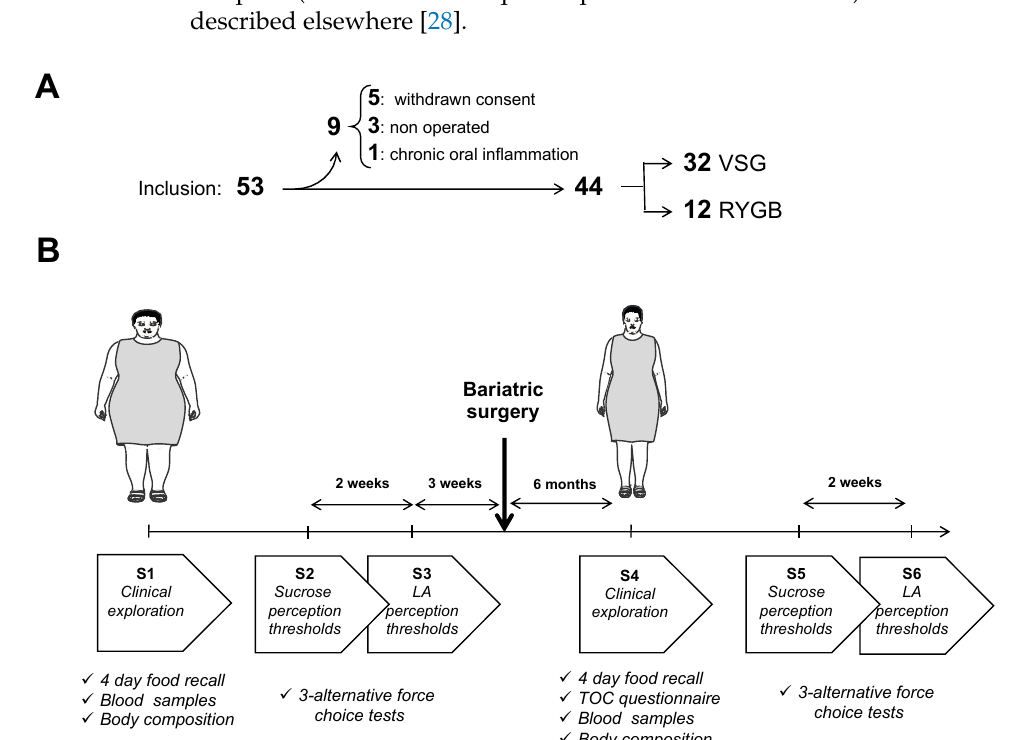
Figure 1. Cohort composition and study design. ( A ) From the 53 patients initially selected, 44 were included, 32 underwent a vertical sleeve gastrectomy (VSG) and 12 a Roux-en-Y gastric bypass (RYGB). ( B ) Before surgery, patients were subjected to 3 successive sessions (S1–S3) including a clinical exploration and the determination of sucrose and linoleic acid (LA) perception thresholds. The same exploratory design was used 6 months after surgery.